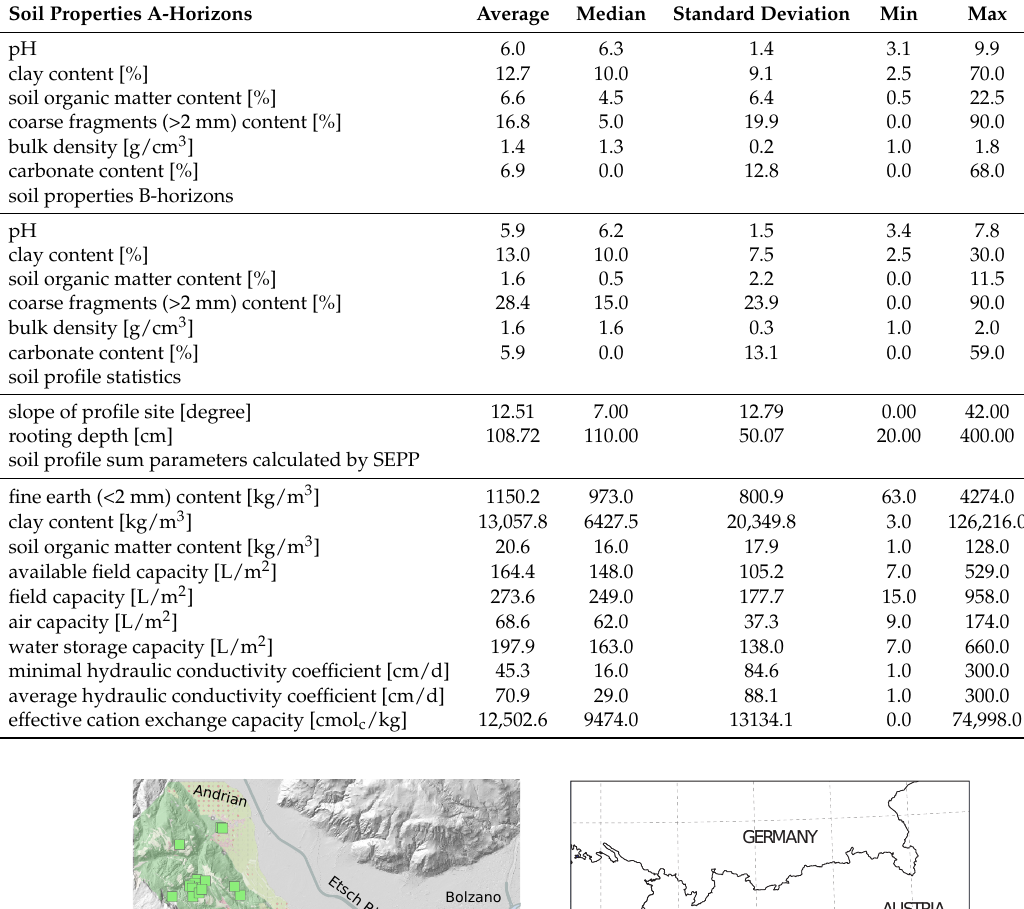
Table 1. Descriptive statistics of the data from the field surveys as well as sum parameters calculated within the SEPP tool which are used as input data for calculating soil function fulfillment levels. For the statistics describing the A and B-horizons, from each soil profile the respective horizon (if present) with the greatest thickness was used for calculation.